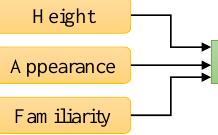
Figure 9. An overview of the ANFIS proposed in